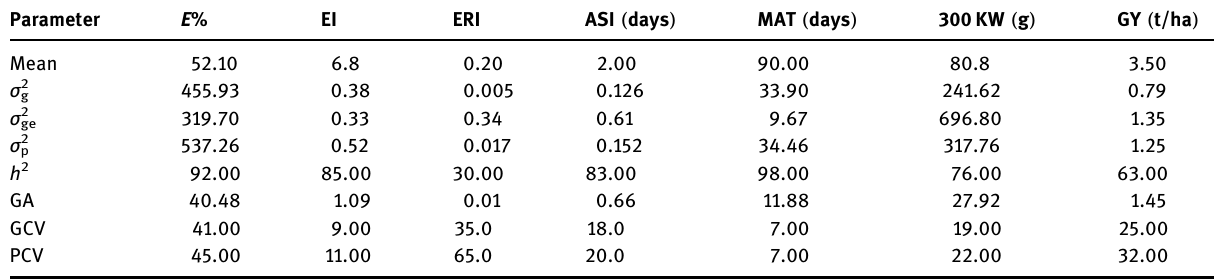
Table 3: Mean, genetic ( σ 2 g ) , genotype × environment interaction ( σ 2 ge ) , phenotypic variance, and heritability estimates ( h 2 ) for emergence and yield traits of 10 maize varieties representing two maize breeding eras in Nigeria evaluated at Orin and Iropora, 2008 and